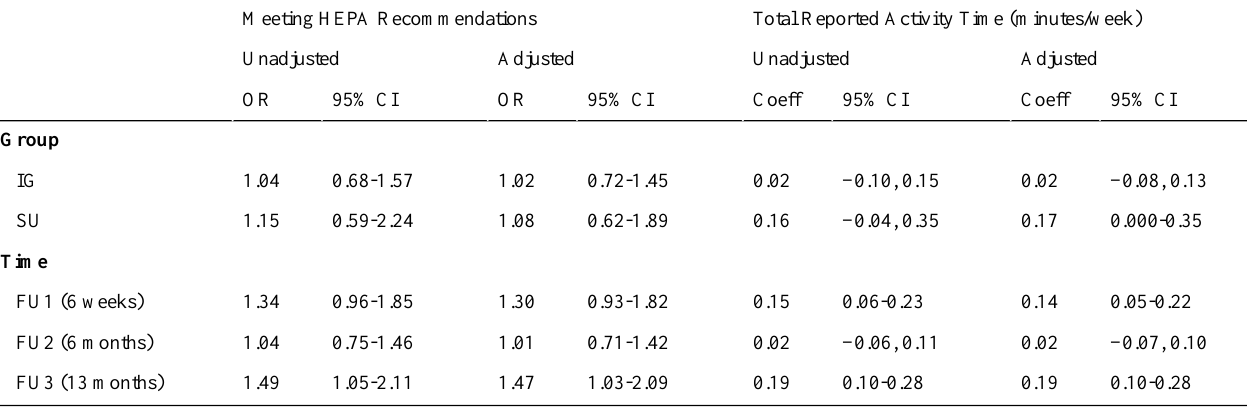
Table 3. Time and group parameters for changes in physical activity, based on mixed logistic and mixed linear models a